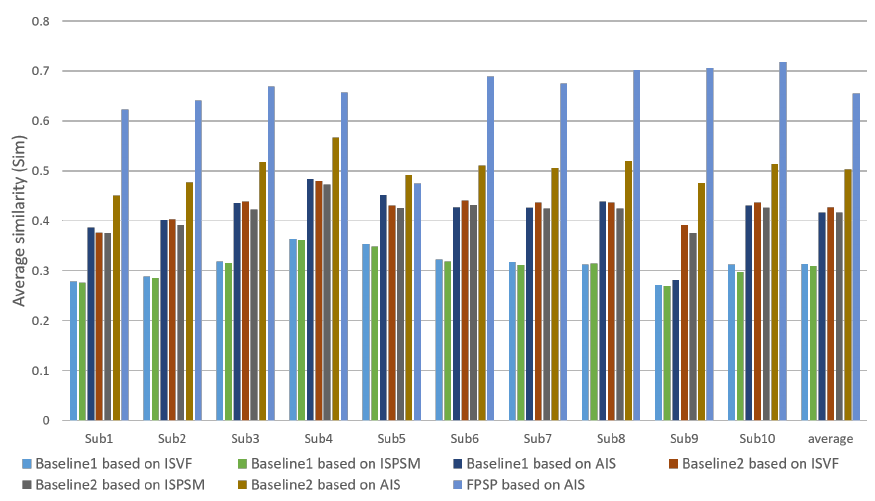
Figure 10. Average similarity (Sim) of each target person ( ↑ ) with comparison to PSM prediction methods.